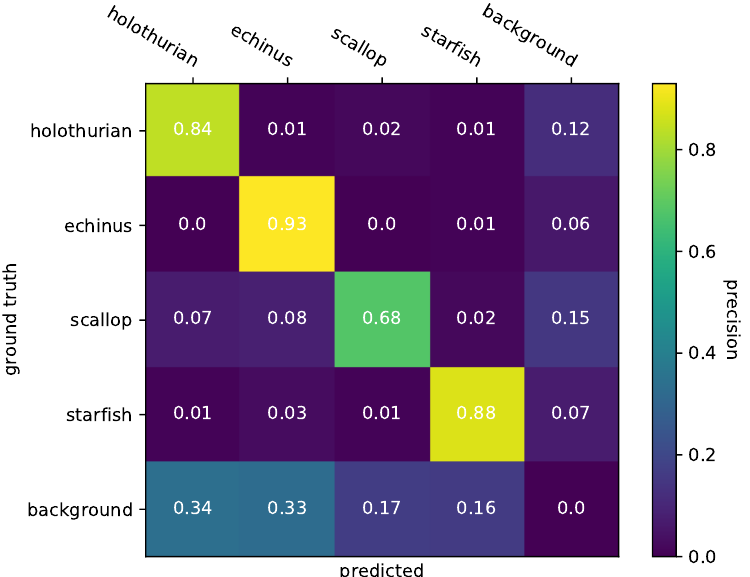
Figure 10. Confusion matrix for the classification branch. All values in the matrix are normalized, and color depths in the matrix represent the magnitude of the different values. As we do not detect the background, the diagonal value of the background is